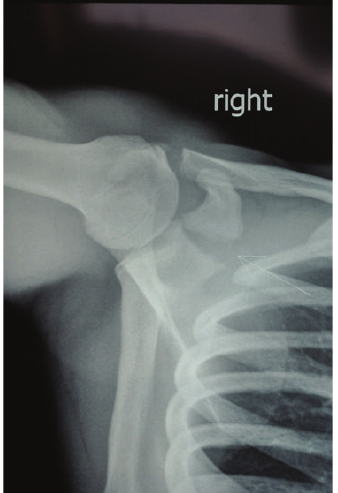
Figure 1: Case A: initial axillary radiograph.